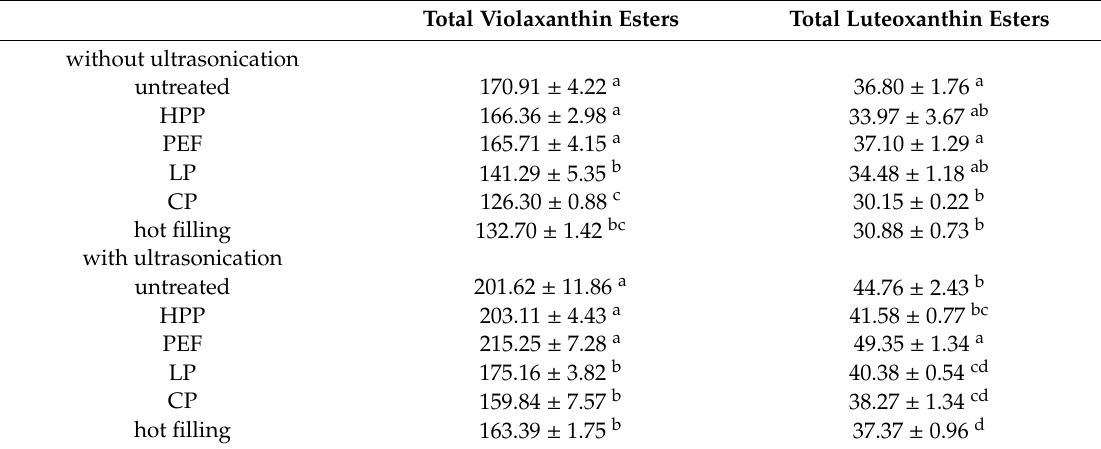
Table 6. Violaxanthin and luteoxanthin ester contents in the total fraction after in vitro digestion of the untreated and pasteurized juices without and with additional ultrasonication. Di ff erent letters indicate significant di ff erences ( p ≤ 0.05). Values are means ± standard deviation ( n =